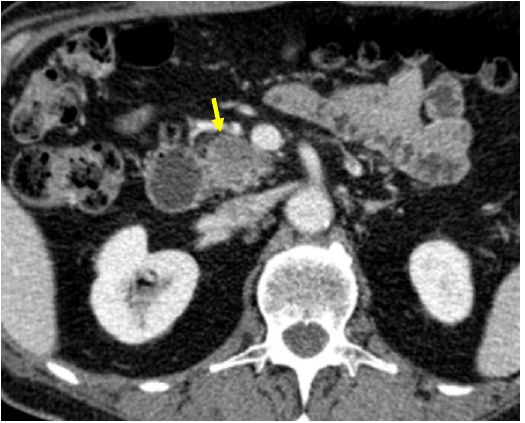
Figure 3. Pancreatic lesion with well-defined margins (arrow) on CT examination in portal-venous contrast phase.